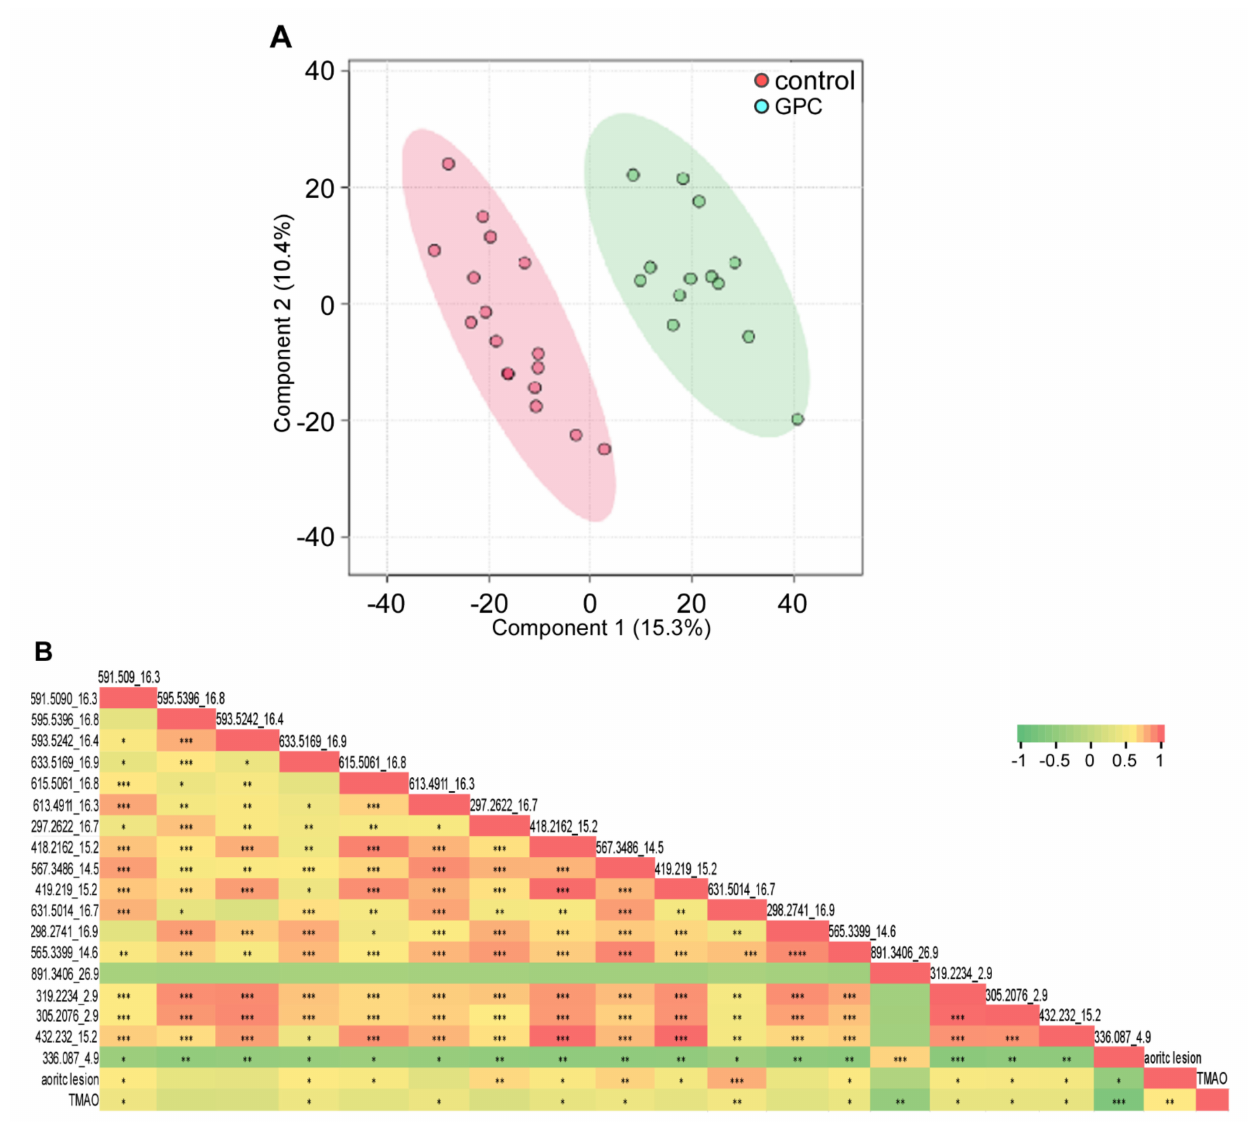
Figure 13. Untargeted metabolomic analysis of plasma metabolites in GPC supplemented chow diet-fed mice versus control chow diet-fed mice. ( A ) PLS-DA of the untargeted metabolomic data in plasma resulted in a clear separation of the metabolic features between female C57BL/6J Apoe − / − mice fed GPC supplemented or control chow diets. ( B ) Pearson correlations (r) among the untargeted metabolomic features with fold change larger and FDR smaller than TMAO by comparison of the two groups and plasma TMAO concentration, aortic lesion area. Untargeted metabolomic features in the plasma of female C57BL/6J Apo e − / − mice fed GPC supplemented or control chow diet for 16 weeks were acquired by LC-Triple TOF 5600 mass spectrometer using positive IDA mode. The acquired data were analyzed by XCMS to extract ion specific feature labeled with m/z and retention time (rt). Plasma TMAO concentration was determined by stable isotope dilution LC-MS. * p < 0.05; ** p < 0.01; *** p <